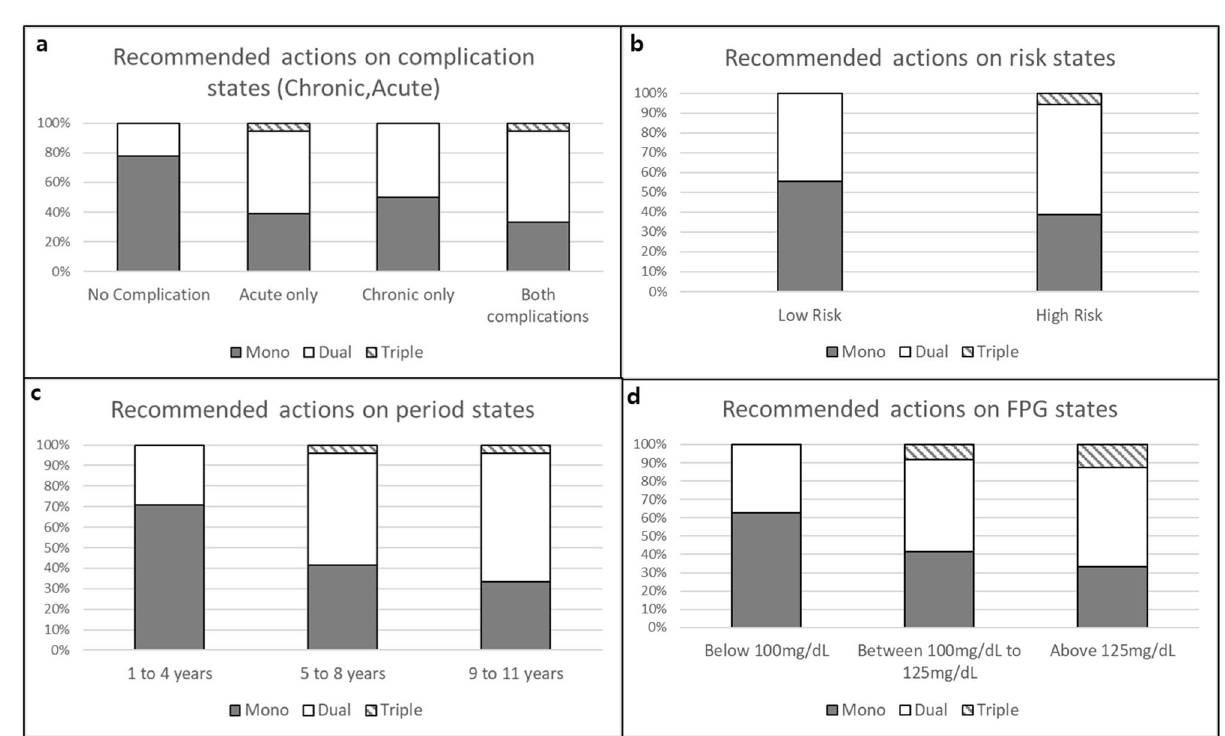
Figure 3. MDP recommendation actions on each state for male patients. This figure shows the recommended treatment actions according to each component of the states for male patients. ( a ) Is the recommended actions on complication states. ( b ) Is the recommended actions on risk states. ( c ) Is the recommended actions on period state and ( d ) is the recommended actions on FPG states. Grey shaded sqaure is for mono therapy recommendations. Open square is for dual therapy recommendations. And striped square is for triple therapy